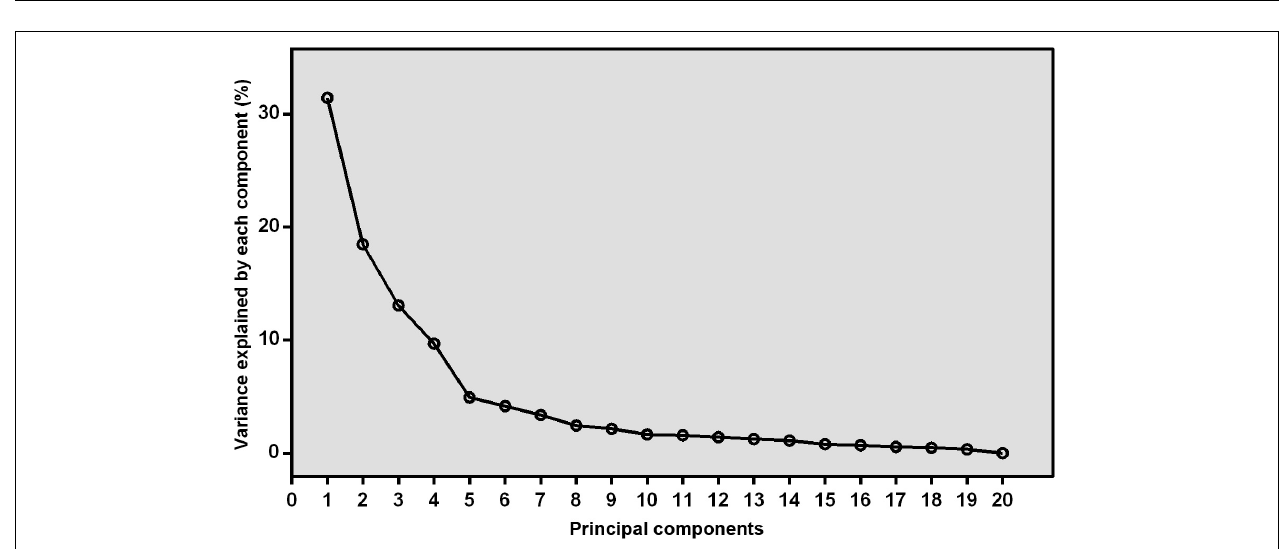
FIGURE 1 | Heat map for spearman correlation matrix of 20 fatty acids measured among 217 GDM cases and matched controls.